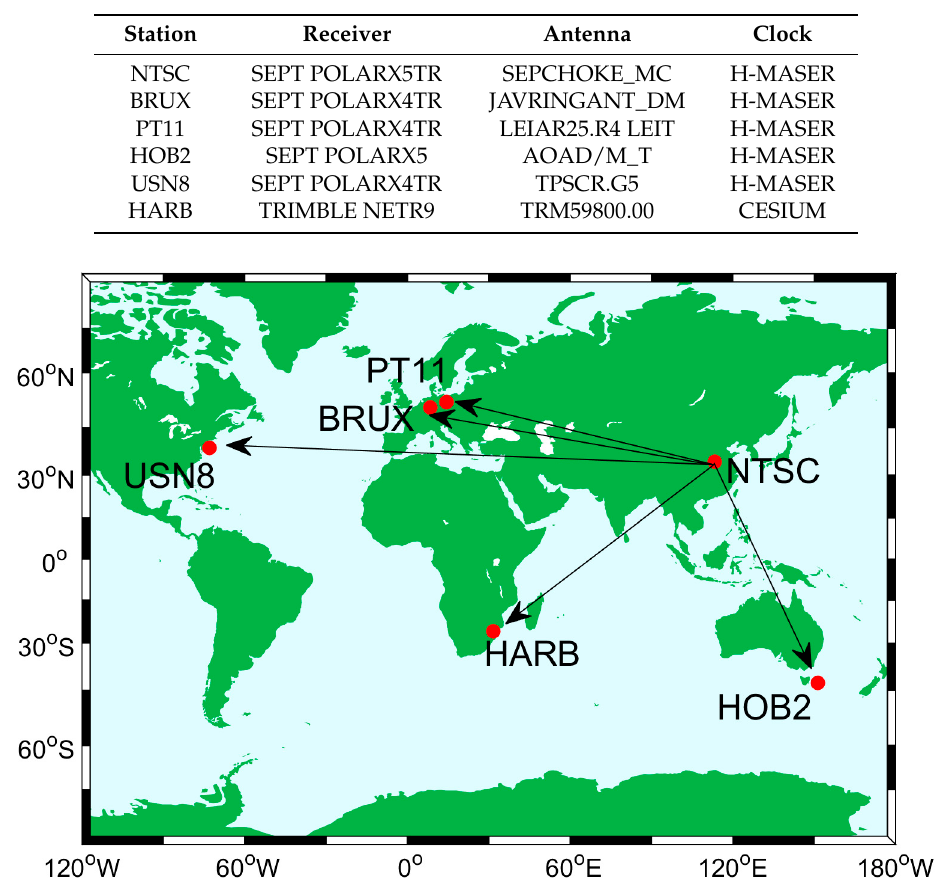
Figure 1. Geographical distribution of the selected 6 GNSS tracking stations. Table 1. The summary of the selected stations from timing laboratories.